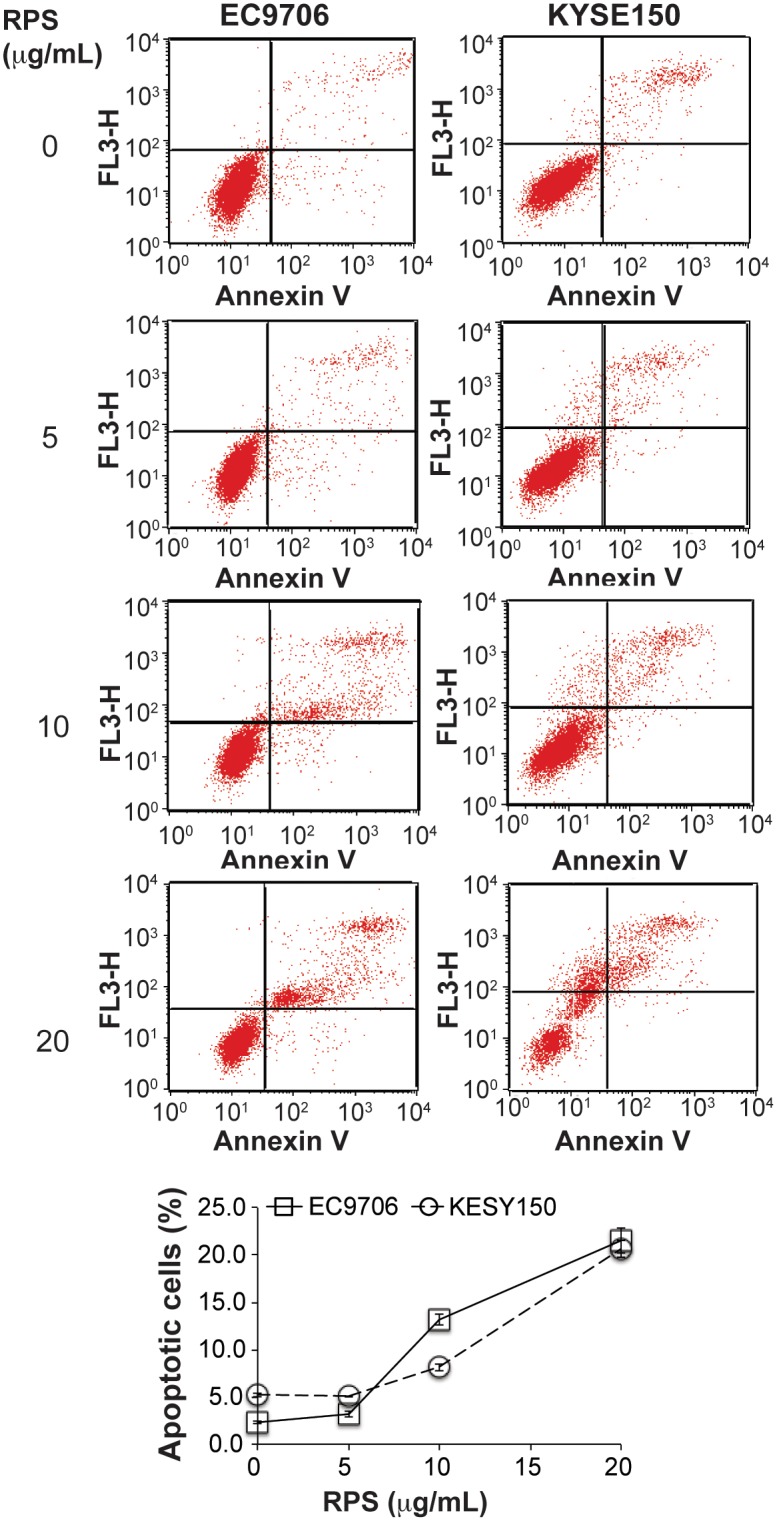
RPS induced apoptosis in esophageal cancer cells.Cells were treated with RPS at 0, 5, 10, or 20 μg/mL for 24 h. Both the attached cells and the floating cells in the media were collected by centrifugation at 1000 g for 5min. Cells were than incubated with 5 μL Annexin V-FITC and 10 μL PI for 15 min in dark, diluted in 200 μL PBS, and analyzed on BD FACS Calibur flow cytometer. Apoptosis was analyzed using FlowJo software, n = 3.